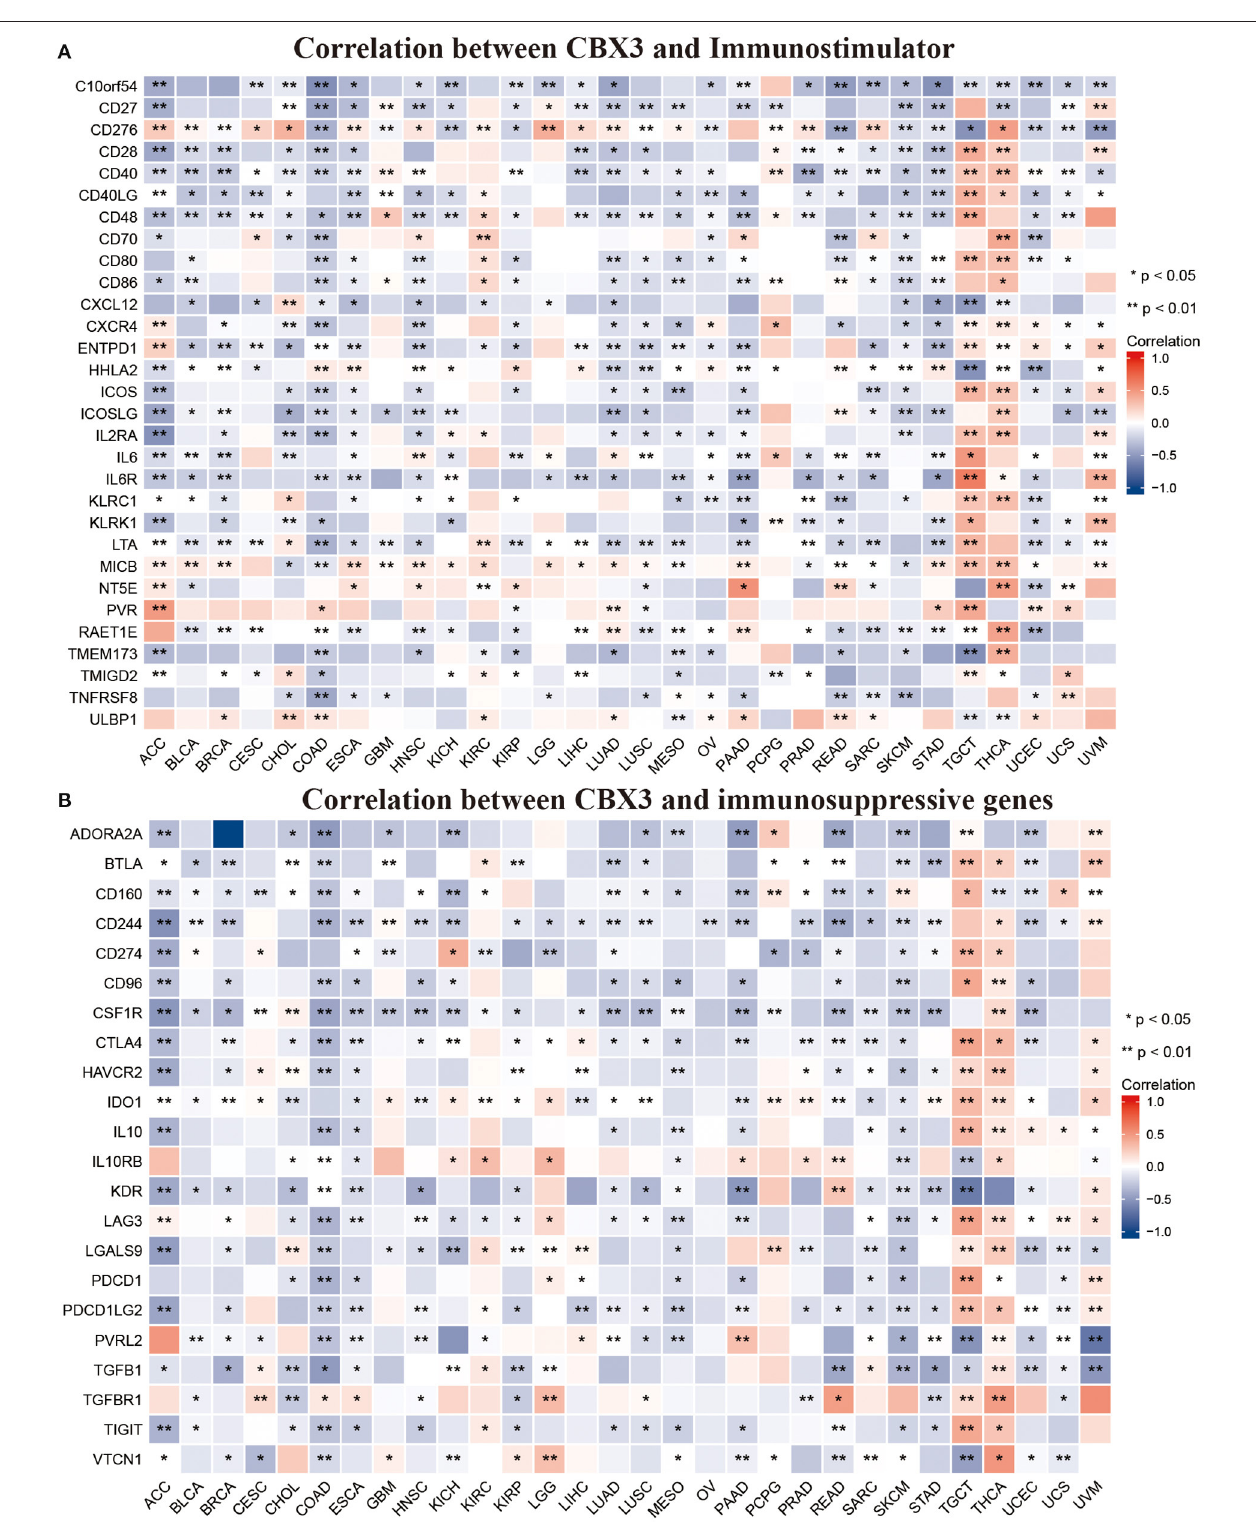
FIGURE 11 | Correlation between CBX3 expression and immunostimulating gene (A) and immunosuppressive gene (B) . * P < 0.05, ** P < 0.01.